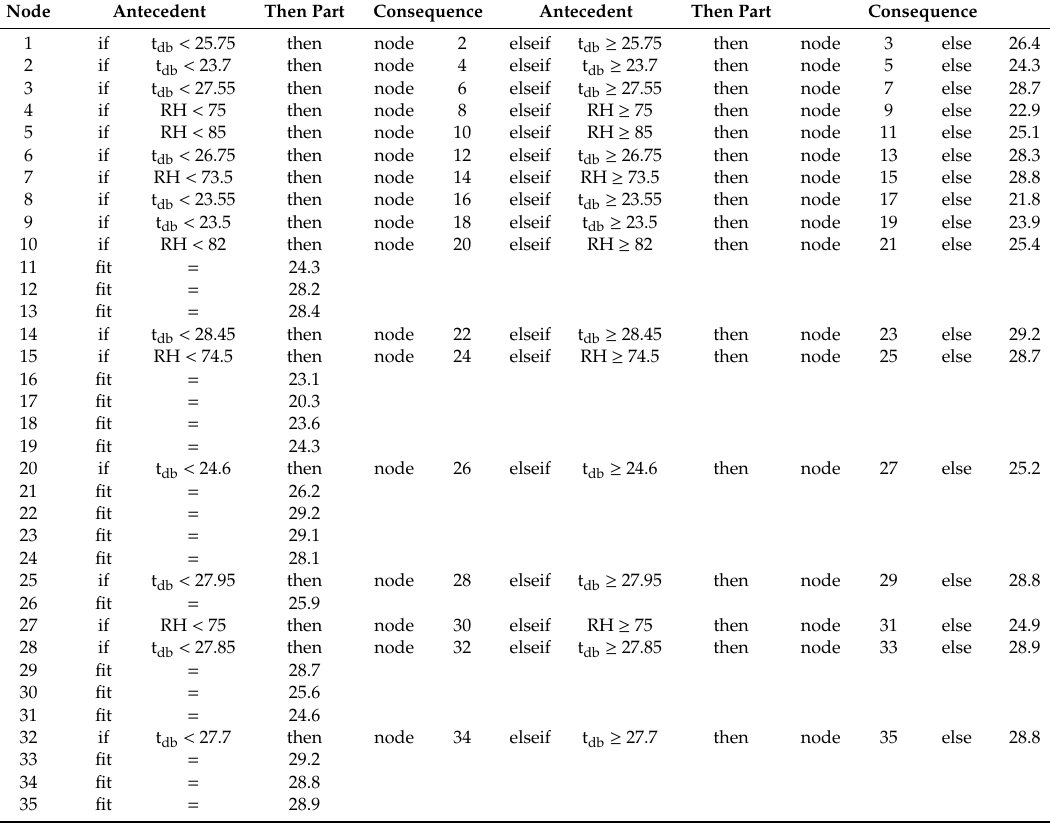
Table 5. Decision-making rule